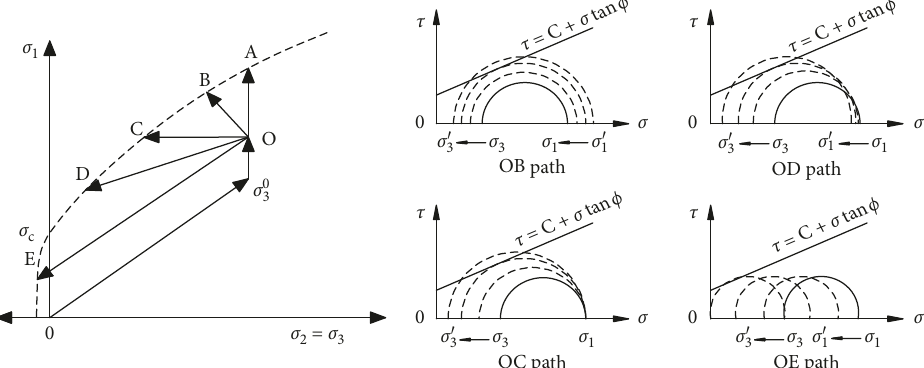
Figure 8: Stress path of unloading confining